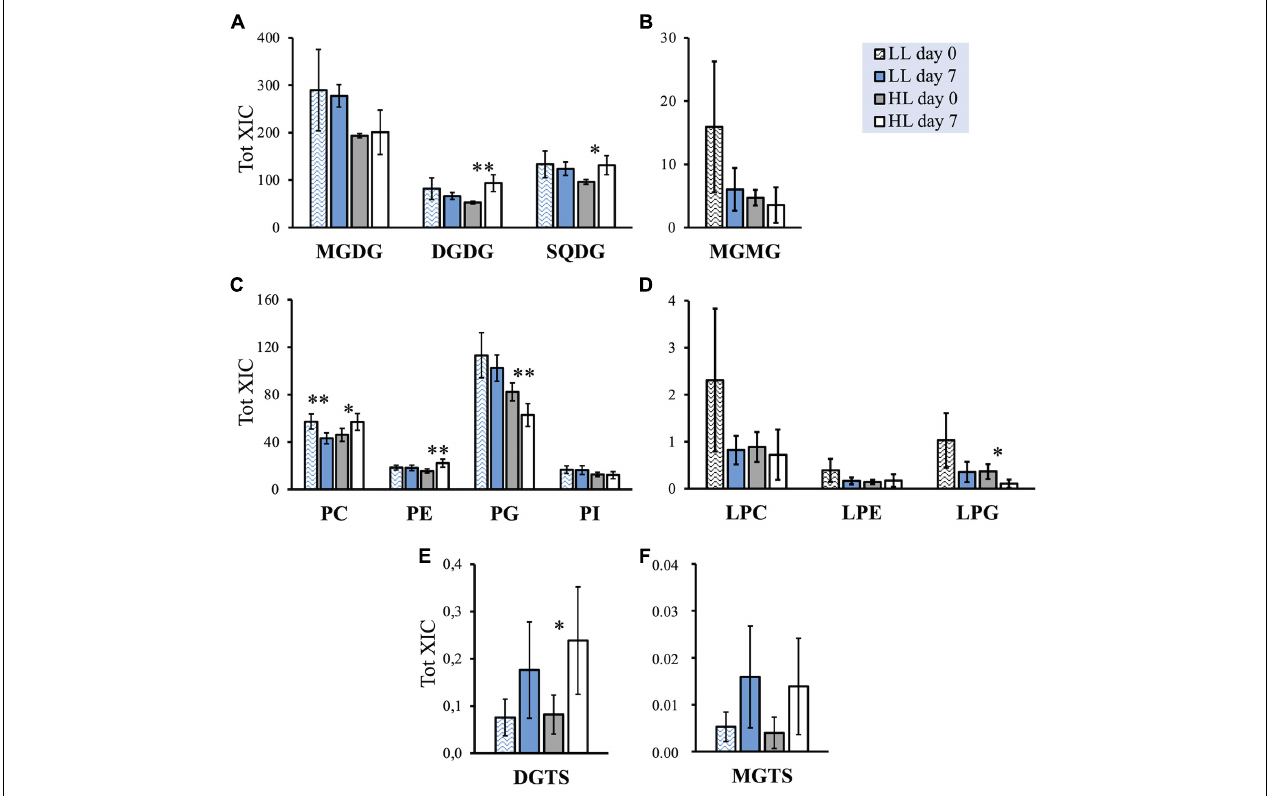
FIGURE 5 | Sum of the normalized extracted ion chromatograms (XIC) areas (mean ± SD; n = 5) of the peaks identified for the lipids species of glycolipid, phospholipid, and betaine lipid classes in Bryopsis plumosa exposed to low light (LL) and high light (HL), at the beginning (day 0) and at the end (day 7) of the light acclimation. (A) Glycolipids (MGDG, DGDG, SQDG); (B) Lyso-forms of glycolipids (MGMG, DGMG); (C) Phospholipids (PC, PE, PG, PI); (D) Lyso-forms of phospolipids (LPC, LPG); (E) Betaine lipids (DGTS); (F) Lyso-forms of betaine lipids (MGTS). Lipid species with values close or equal to 0 (DGMG, SQMG, and LPI) are not reported. Asterisks indicate significant differences between day 0 and day 7, within the same light condition ( t -test): ∗ p < 0.05; ∗∗ p <